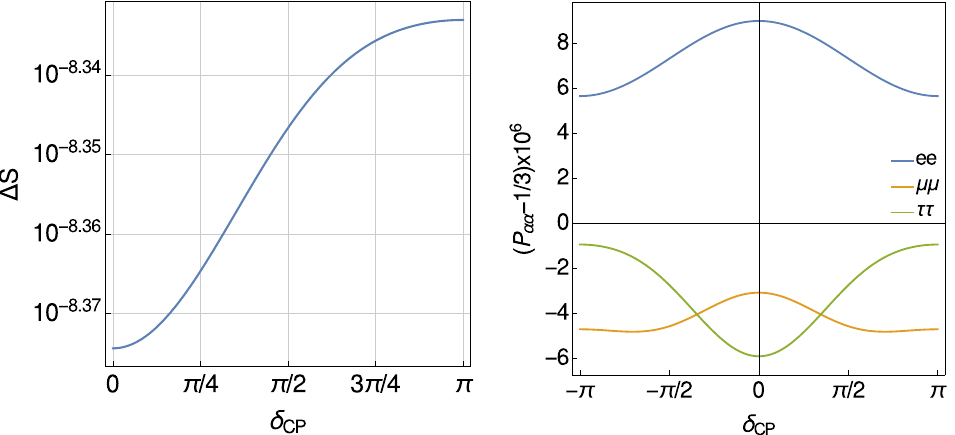
Figure A1. Change in entropy (left) and flavour imbalance (right) after decoherence as a function of CP-violation phase. Initial spectral distortions δ and β are both fixed to the value 10 − 4 . The values for the mixing angles are given by the global fit of neutrino oscillation data [40] for normal